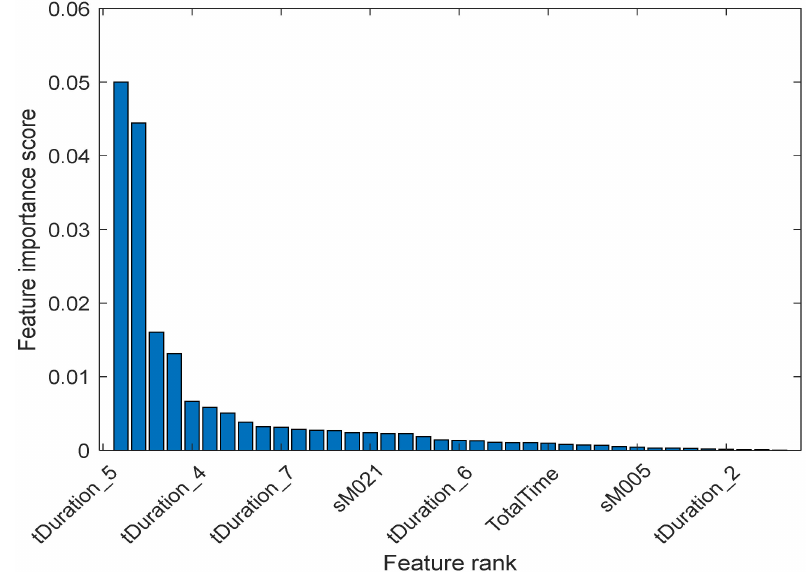
Figure 9. All the feature ranking based on importance